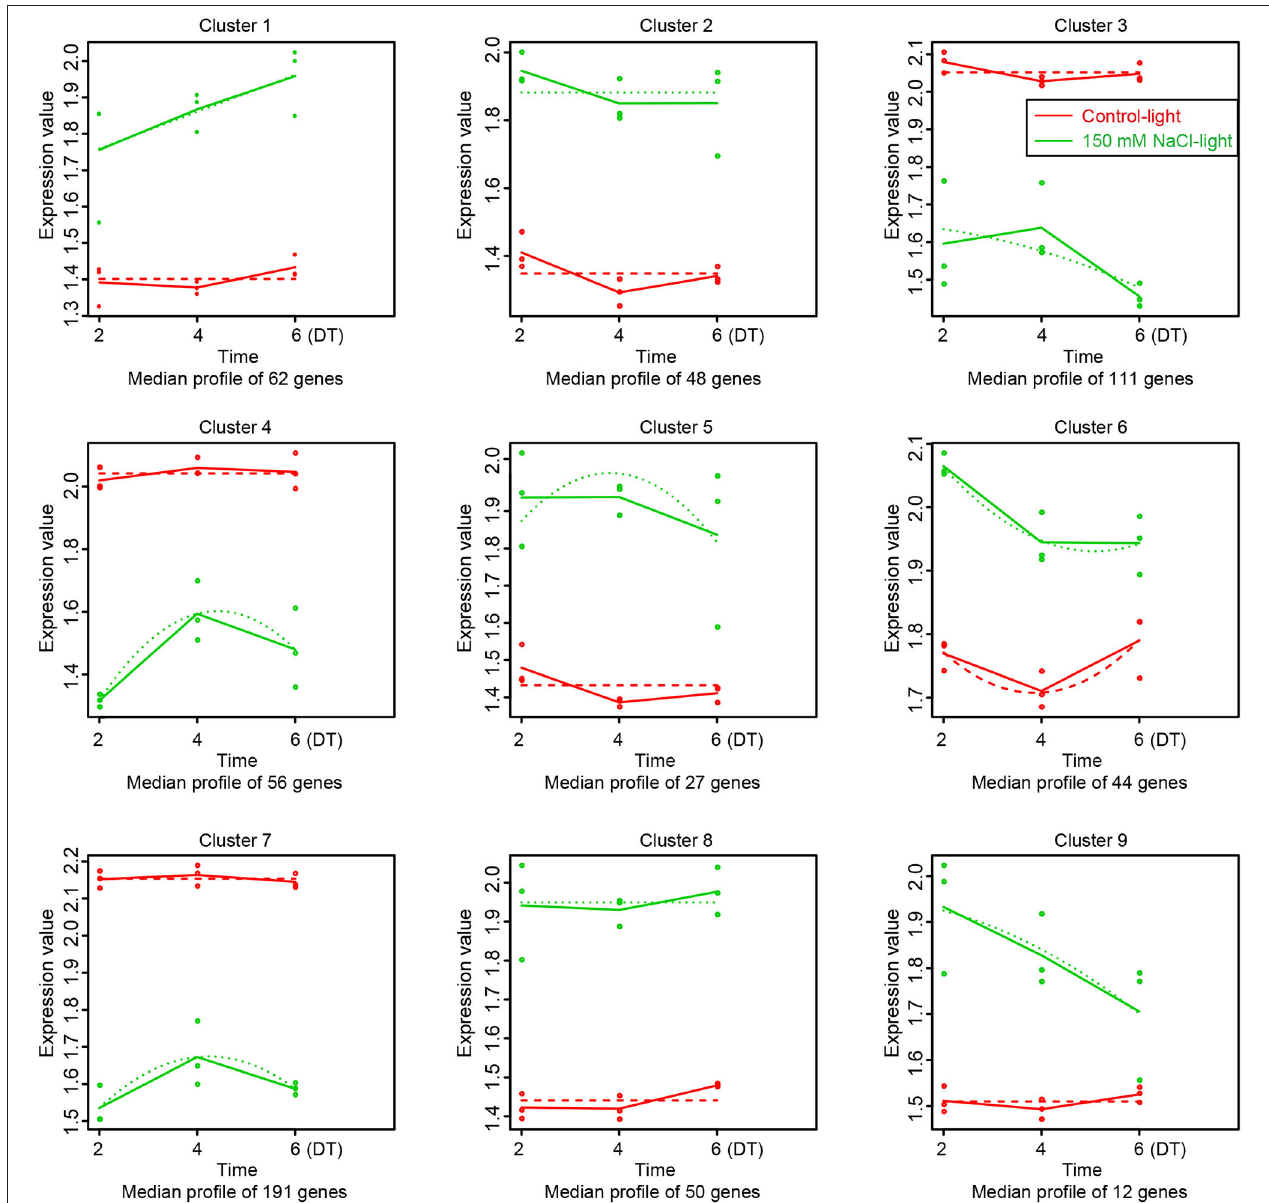
FIGURE 6 | Data visualization with maSigPro (https://www.ncbi.nlm.nih.gov/pmc/articles/PMC4155246/). Each line chart shows the average expression profile of the gene clusters. Horizontal axis represents different time points, vertical axis represents average expression values. Different colored lines represent different groups (red and green lines represent the control-light and 150mM NaCl-light groups, respectively). Dotted lines represent Fitted curves of the gene expression at each time